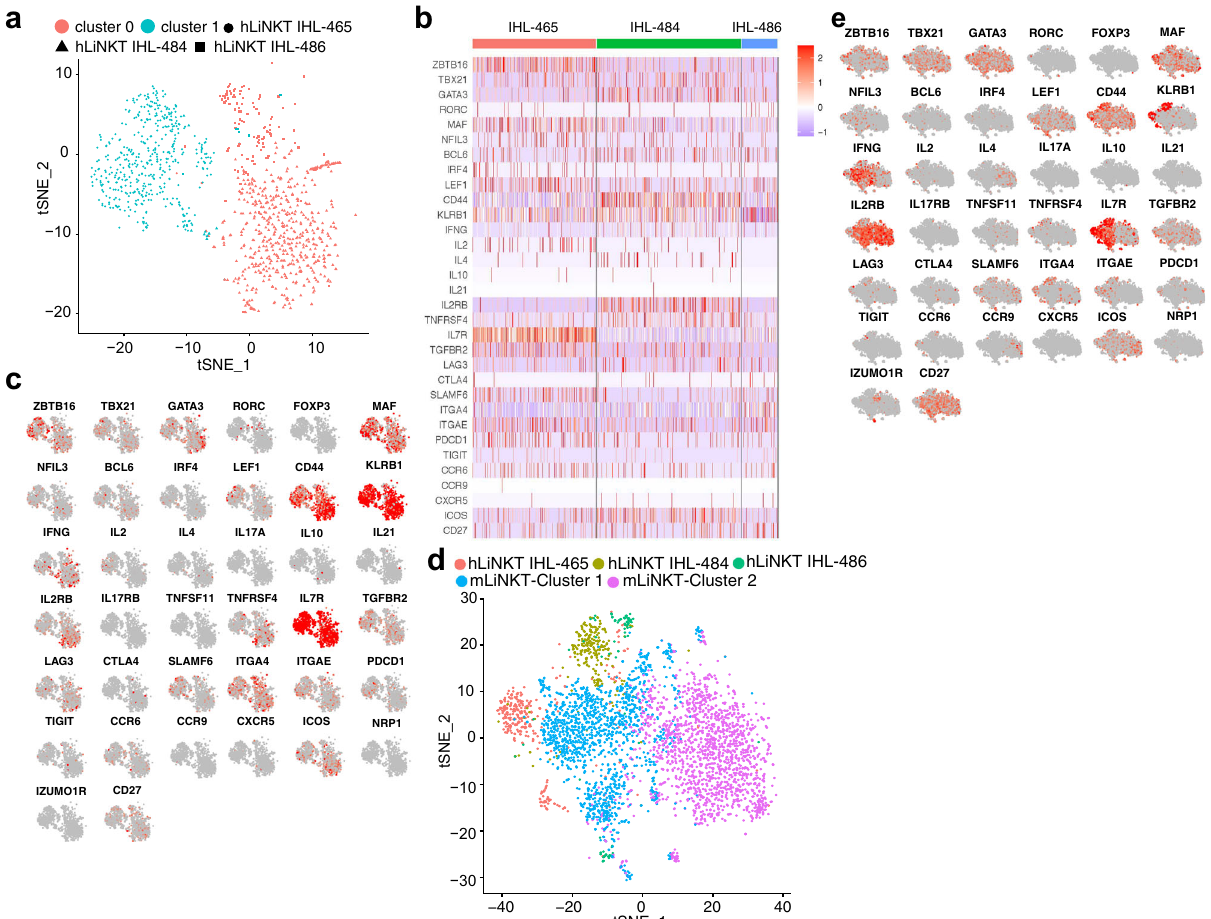
Fig. 5 Single-cell RNAseq for human LiNKT cells. a tSNE plots from hLiNKT cells sorted from three different human liver explants. Each sample is labeled with a different symbol. The clusters the samples belong to are identi fi ed with different colors. b Heatmaps comparing expression levels for the genes from Suppl. Table 1 in the 3 hLiNKT cell samples. c Feature maps showing the cell cluster location of gene expression for the genes from Table 1. d , e Integrated tSNE plots ( d ) and feature maps ( e ) of mLiNKT clusters #1 and #2 and the three hLiNKT samples